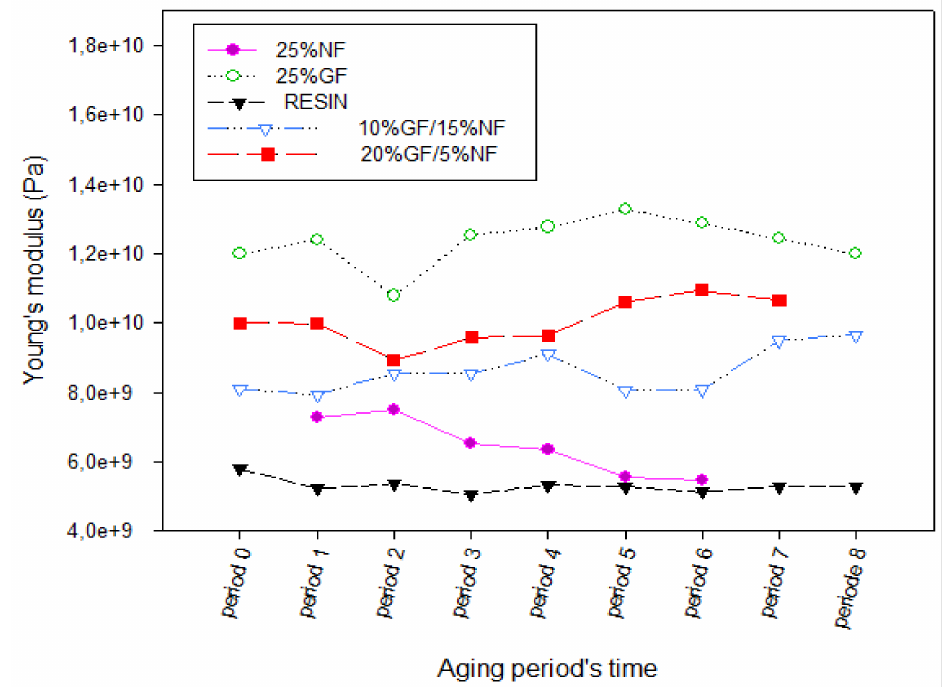
Figure 9. Young’s modulus vs. aging period’s